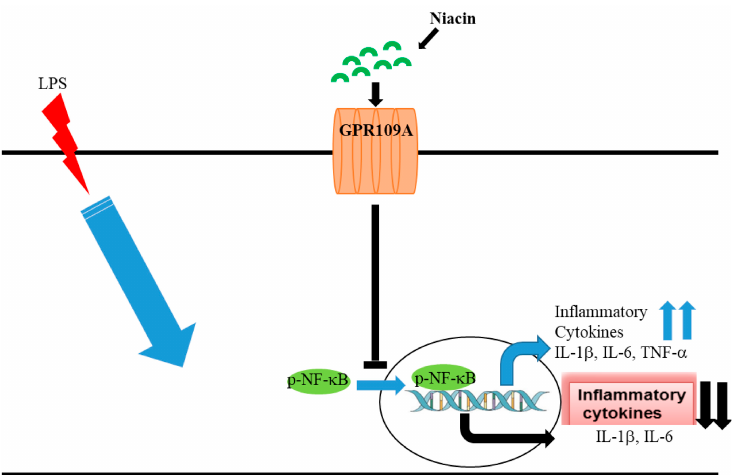
Figure 7. Inhibitory activity of niacin on LPS induced p-NF- κ B signaling cascade and transcriptional regulation of inflammatory cytokines.